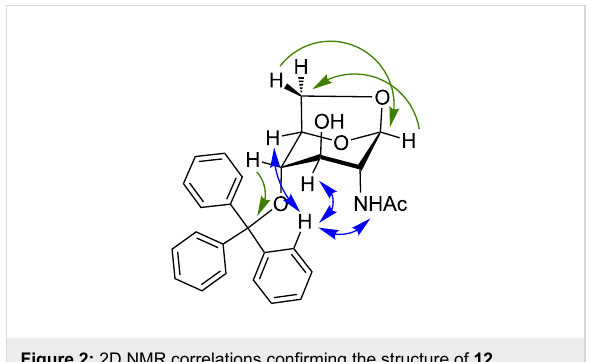
Figure 2: 2D NMR correlations confirming the structure of 12 .